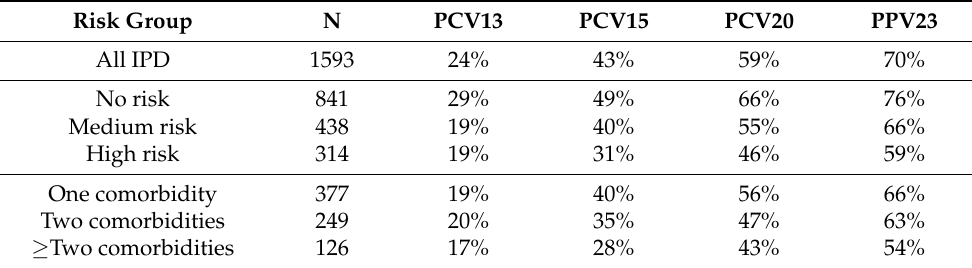
Table 3. Invasive pneumococcal disease in the population ≥ 5 years by vaccine serotype and medical risk group, Norway